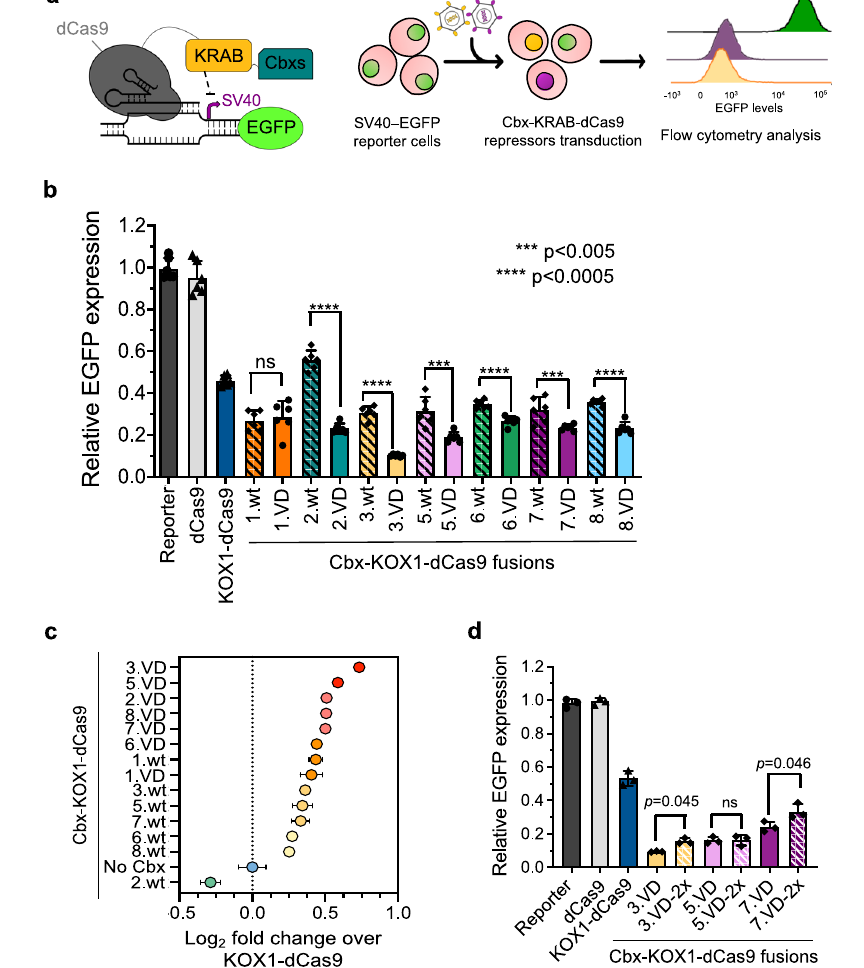
Fig. 4 | Effects of high-af fi nity chromodomains on CRISPRi ef fi ciency. a Sche- matic representation ofthe reporter cell line and CRISPR-based repressorsusedin the assay. EGFP expression is driven by an SV40 promoter and Cbx-KRAB-dCas9 fusions are recruited to the SV40-EGFP reporter by stably expressing a gRNA tar- geting the SV40 promoter. KOX1-dCas9 and Cbx-KOX1-dCas9 repressors were delivered into the reporter cell line by lentiviral infection and EGFP silencing was measured by fl ow cytometry. b EGFP expression levels were measured by fl ow cytometry 20 days after cell infection. Each bar represents the geometric mean of fl uorescencesignalsrelativetountransducedreportercells( n =6,±1SD),witheach data point showing a biological replicate. c Log 2 fold change repression ef fi ciency of Cbx-KOX1-dCas9 fusions in comparison to KOX1-dCas9 (no Cbx). Data are as